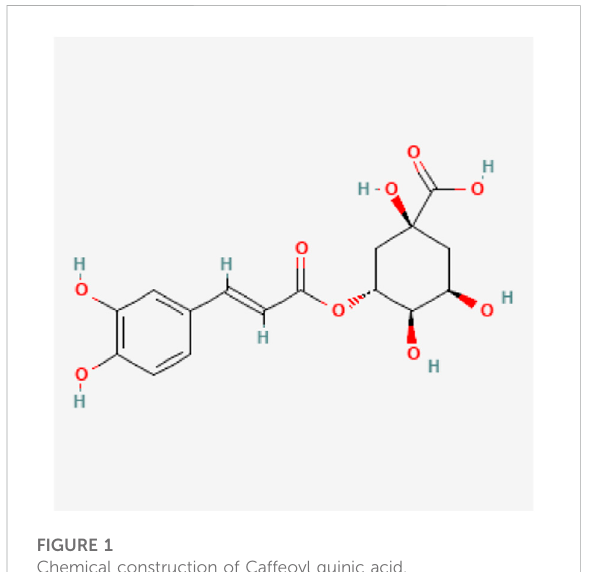
FIGURE 1 Chemical construction of Caffeoyl quinic